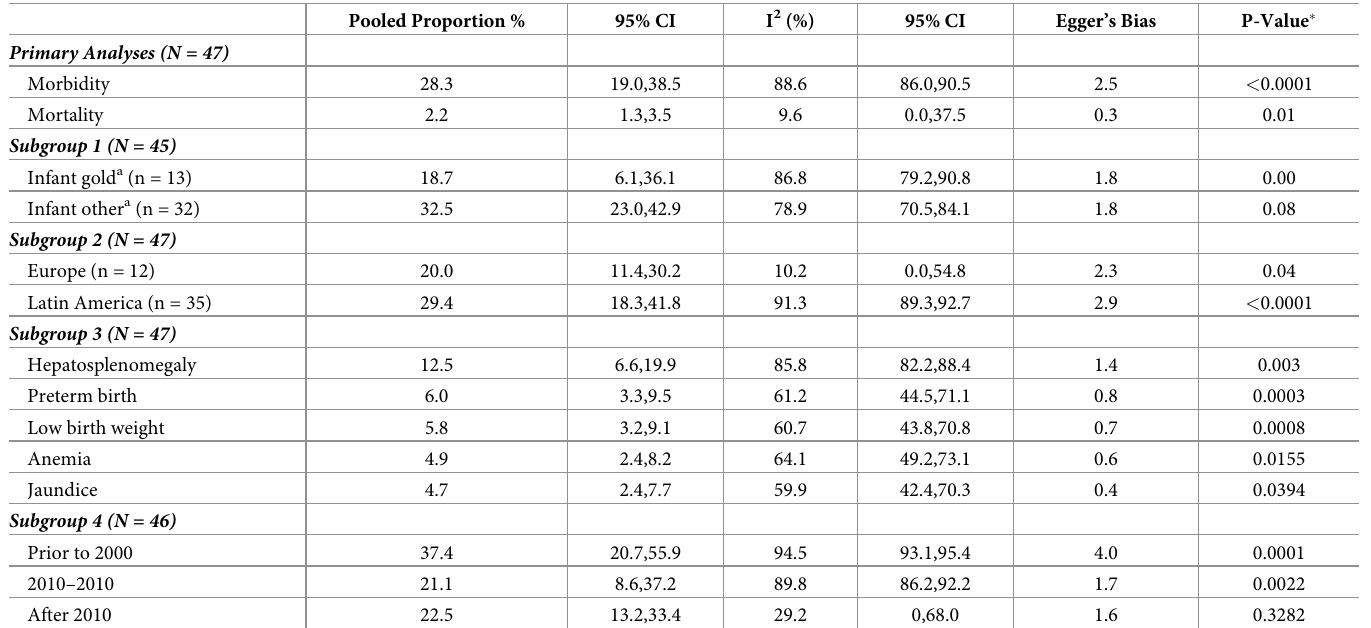
� Egger’s Bias plot statistical significance for asymmetry a Gold standard diagnosis for infants is defined as confirmation of infection at birth using parasitological examination (microhematocrit or microStrout testing methods), and if negative follow-up parasitological examination if negative, and at 10 months two serological